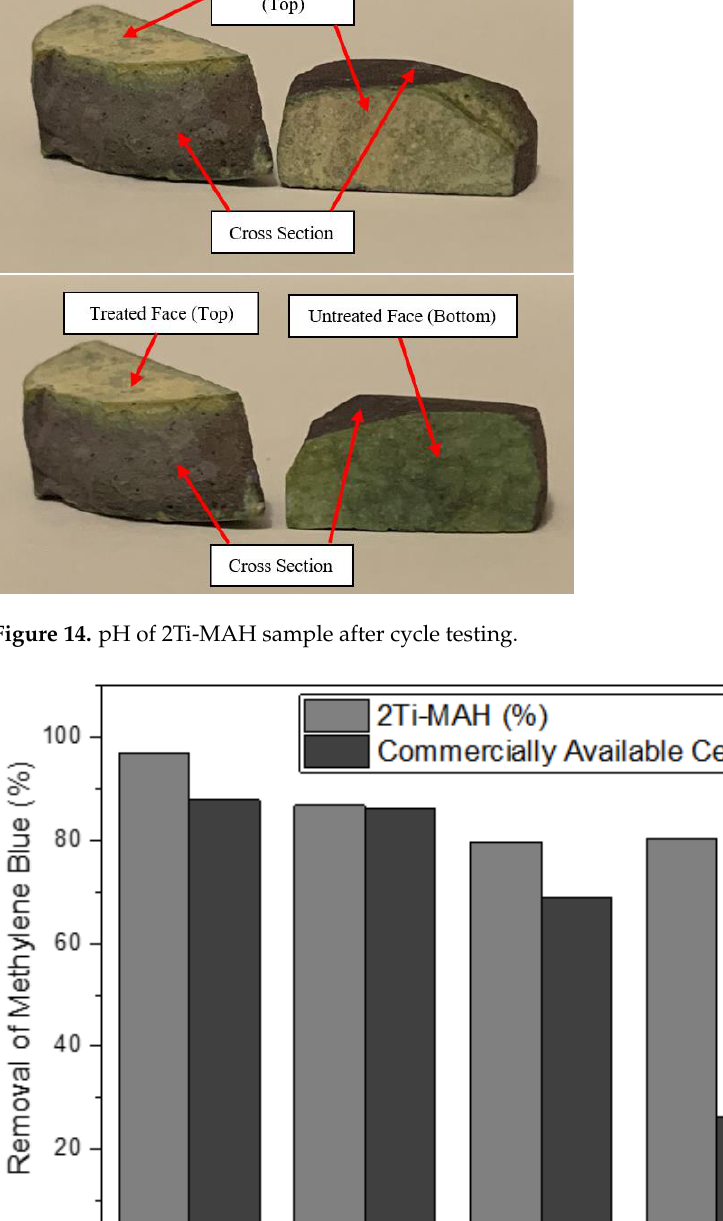
Figure 14. pH of 2Ti-MAH sample after cycle testing.